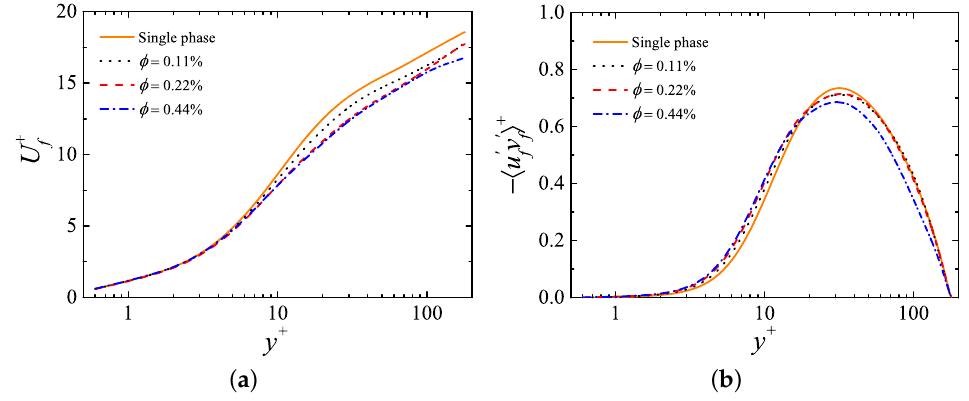
Figure 3. Comparison of results between the single-phase flow and the particle-laden flows: ( a ) Fluid mean streamwise velocity profiles and ( b ) fluid Reynolds stress